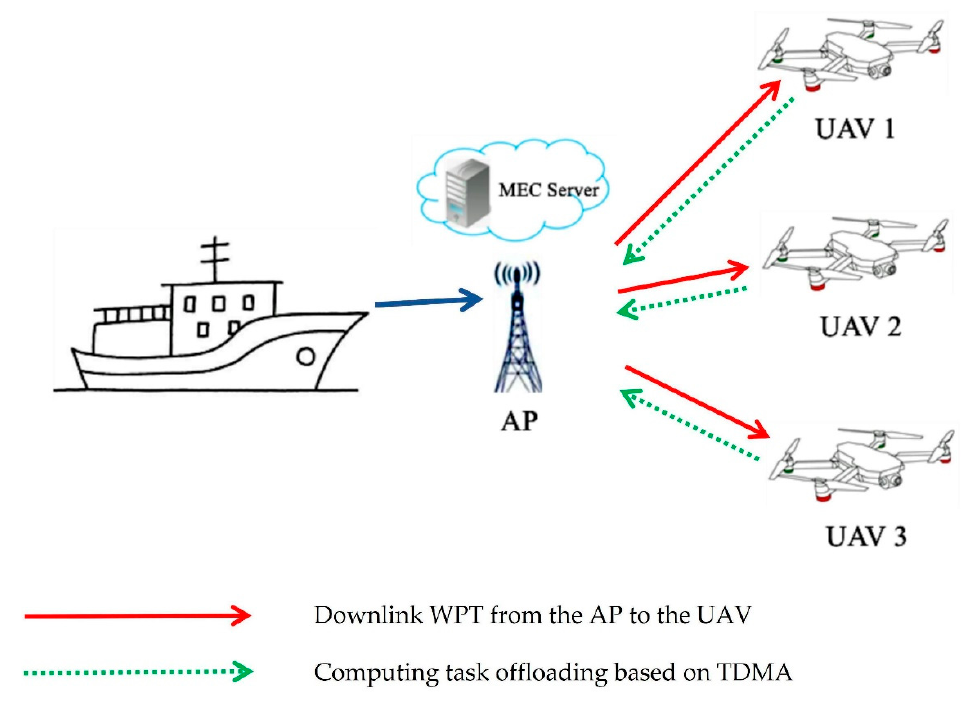
Figure 1. System